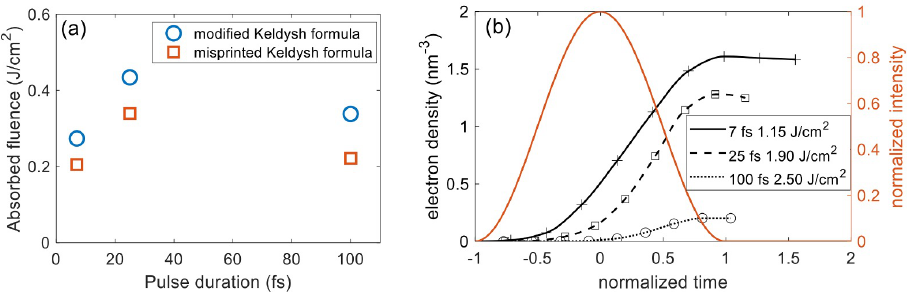
Figure 10. Comparison of the cumulative absorbed fluence ( a ) and electron density evolution ( b ) at LID threshold fluence calculated by the uncorrected and modified/corrected Keldysh formulae. The orange curve represents the intensity profile of the laser pulse and the time is normalized by the pulse duration. The pulse parameters are the same as those in Figure 9. The crosses, squares, and circles in ( b ) represent the simulation data points for the 7 fs, 25 fs, and 100 fs pulses,